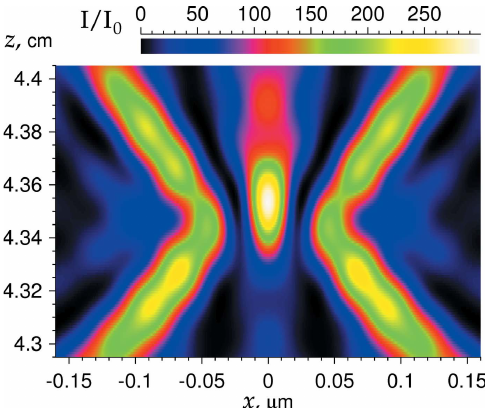
Figure 4 Relative intensity distribution near the focal distance for the parameters as in Fig. 2, but with a tungsten wire in front of the PCRL. See details in the